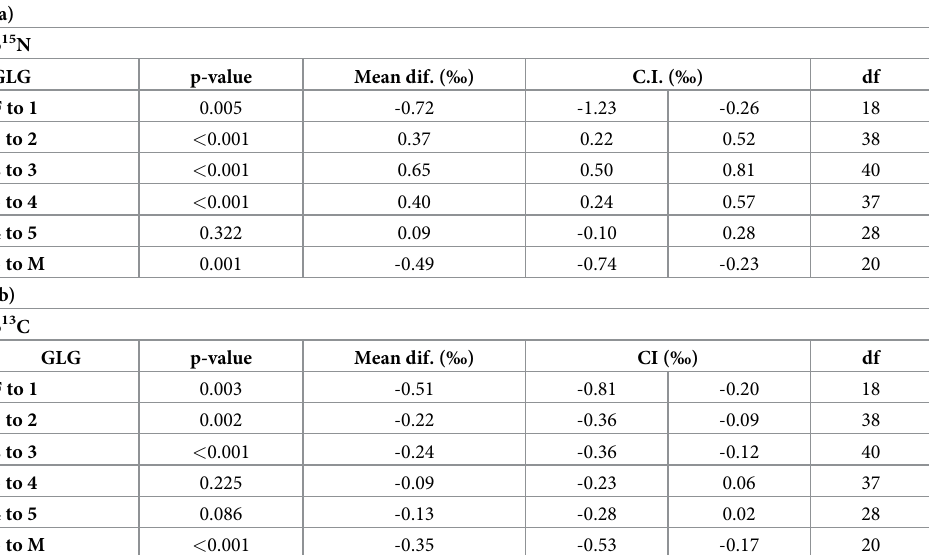
Table 3. Paired t-test results for comparisons between GLG years within individuals for (a) δ 15 N and (b) δ 13 C. Test significance (p-value), mean difference in ‰ (Mean dif. ‰), confidence intervals of the difference (C.I. ‰) and degrees of freedom (df) are presented for each